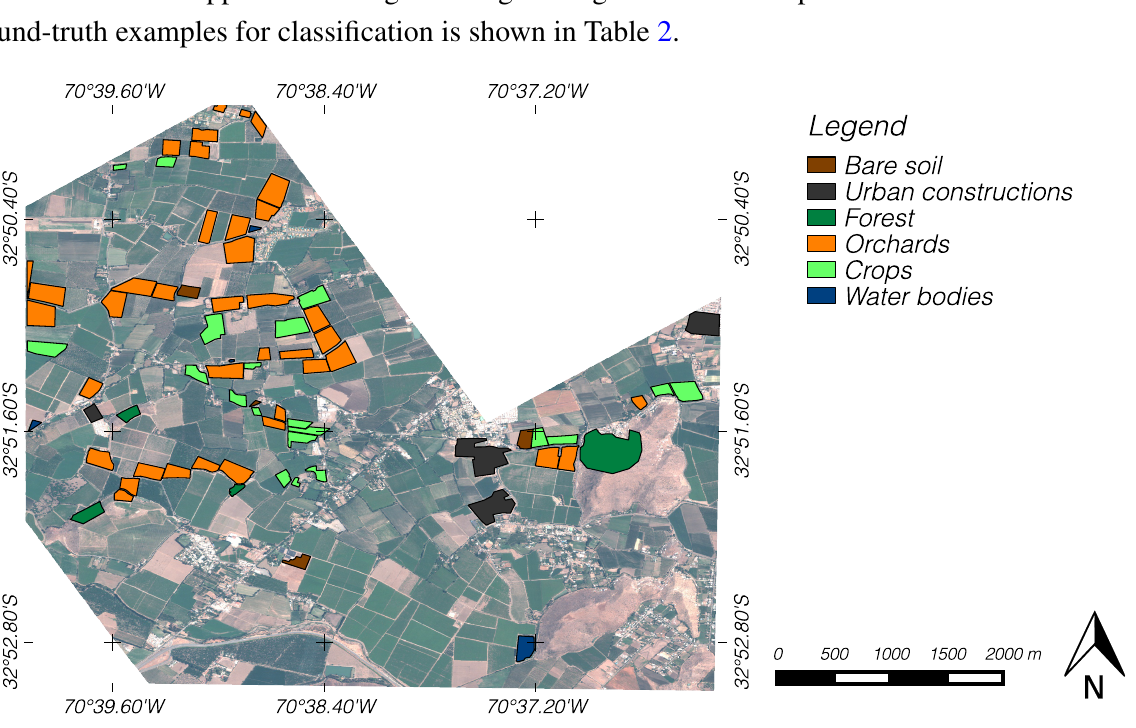
Figure 2. Real color composition (red, green and blue bands) of the Quickbird image. The polygons corresponding to the interest classes are overlapped on the image. Table 2. Class distribution of the available ground-truth examples. The percentage represents the area that covers a class regarding the total area of the